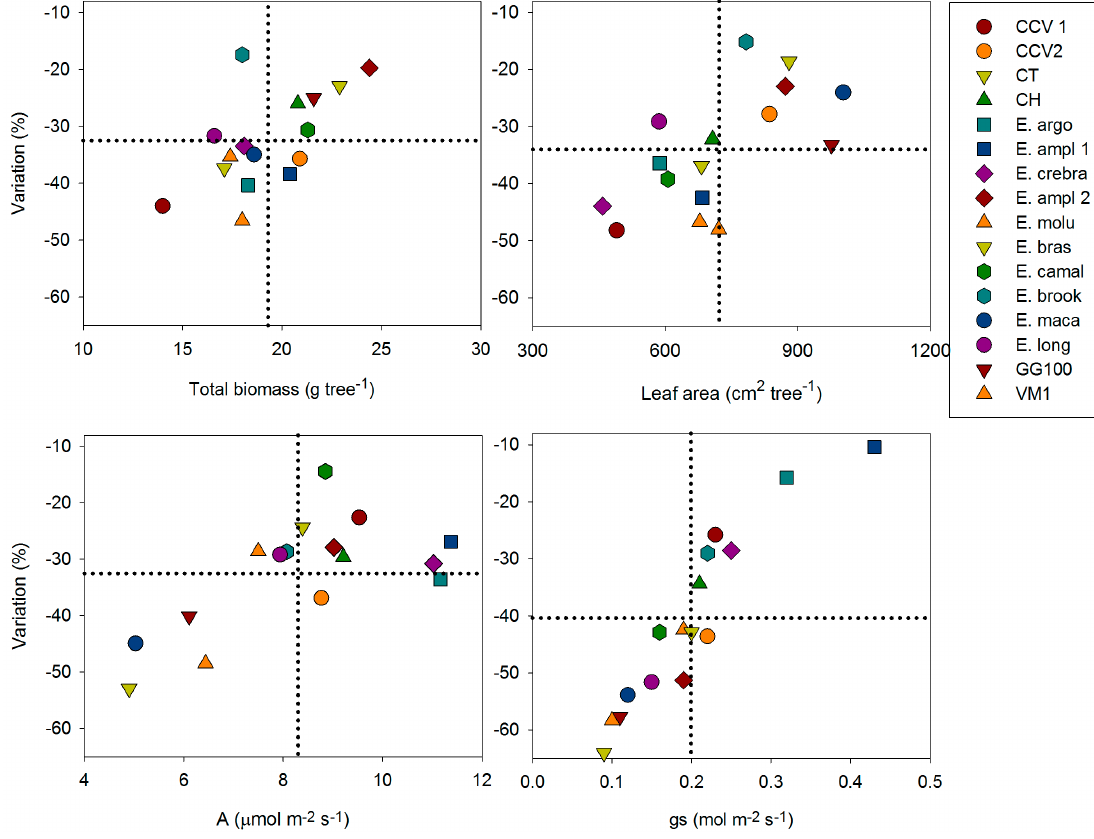
Figure 1. Absolute total biomass, stomatal conductance (gs), photosynthetic rate (A), and leaf area under water limited conditions for the 16 taxa and their relative decrease under water limited regime. Dotted lines represent the average values of all taxa at both axes.